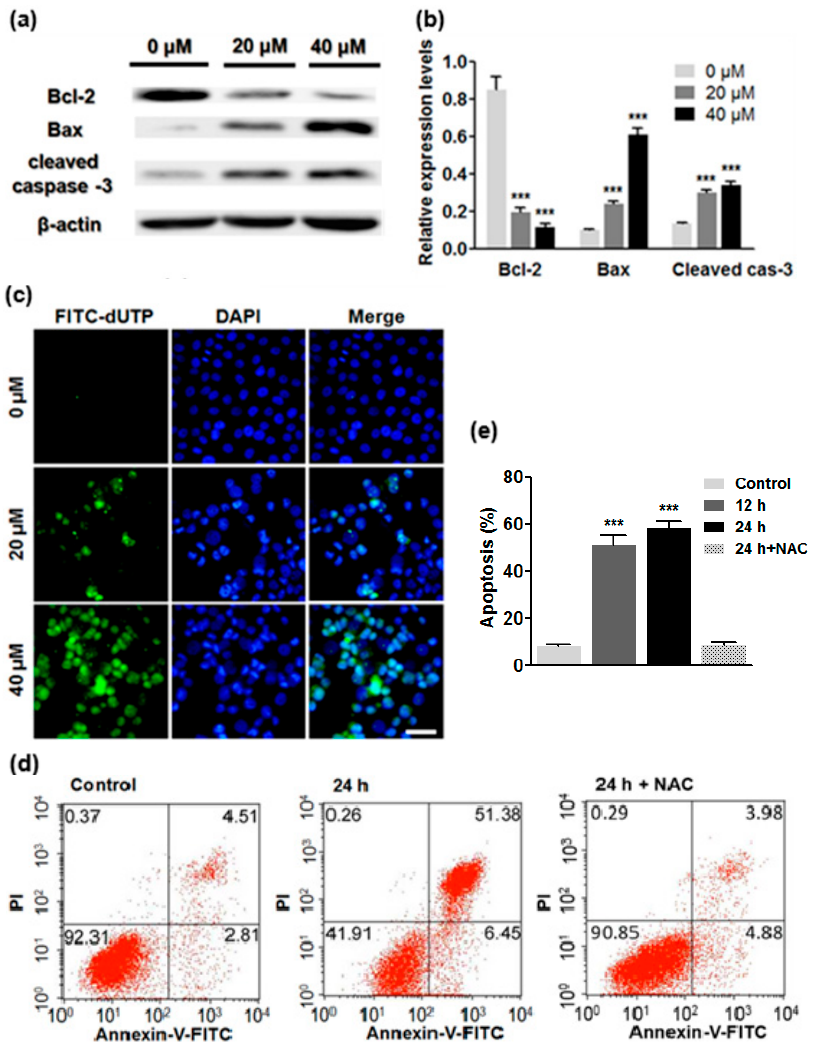
Figure 5. ATL treatment induced marked apoptosis. ( a , b ) Western blot analysis of apoptosis proteins: pro-apoptotic proteins Bax and active caspase-3 were significantly upregulated, while anti-apoptotic Bcl-2 was downregulated in SW480 and SW1116 cancer cells treated with 40 μ M